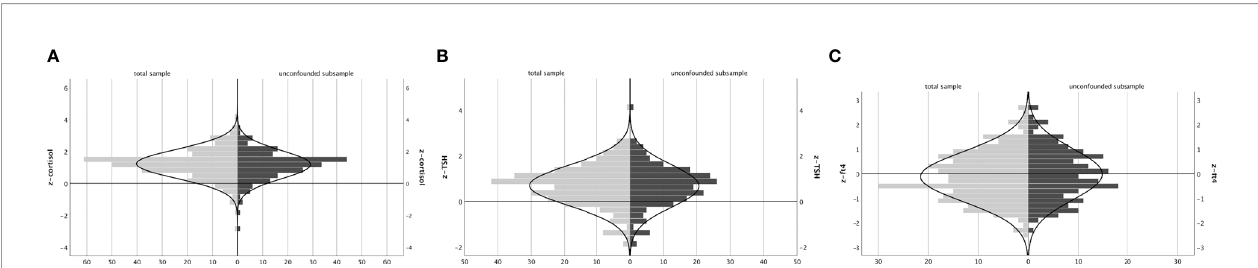
FIGURE 1 | Frequencies of z-standardized (A) cortisol, (B) TSH, and (C) fT4 levels with an overlaid normal distribution curve, separately plotted for the total sample and the subsample of patients without the intake of medication affecting endocrine functioning. The horizontal line indicates z = 0 and, therefore, the mean of the reference sample used for calibration of the respective hormone